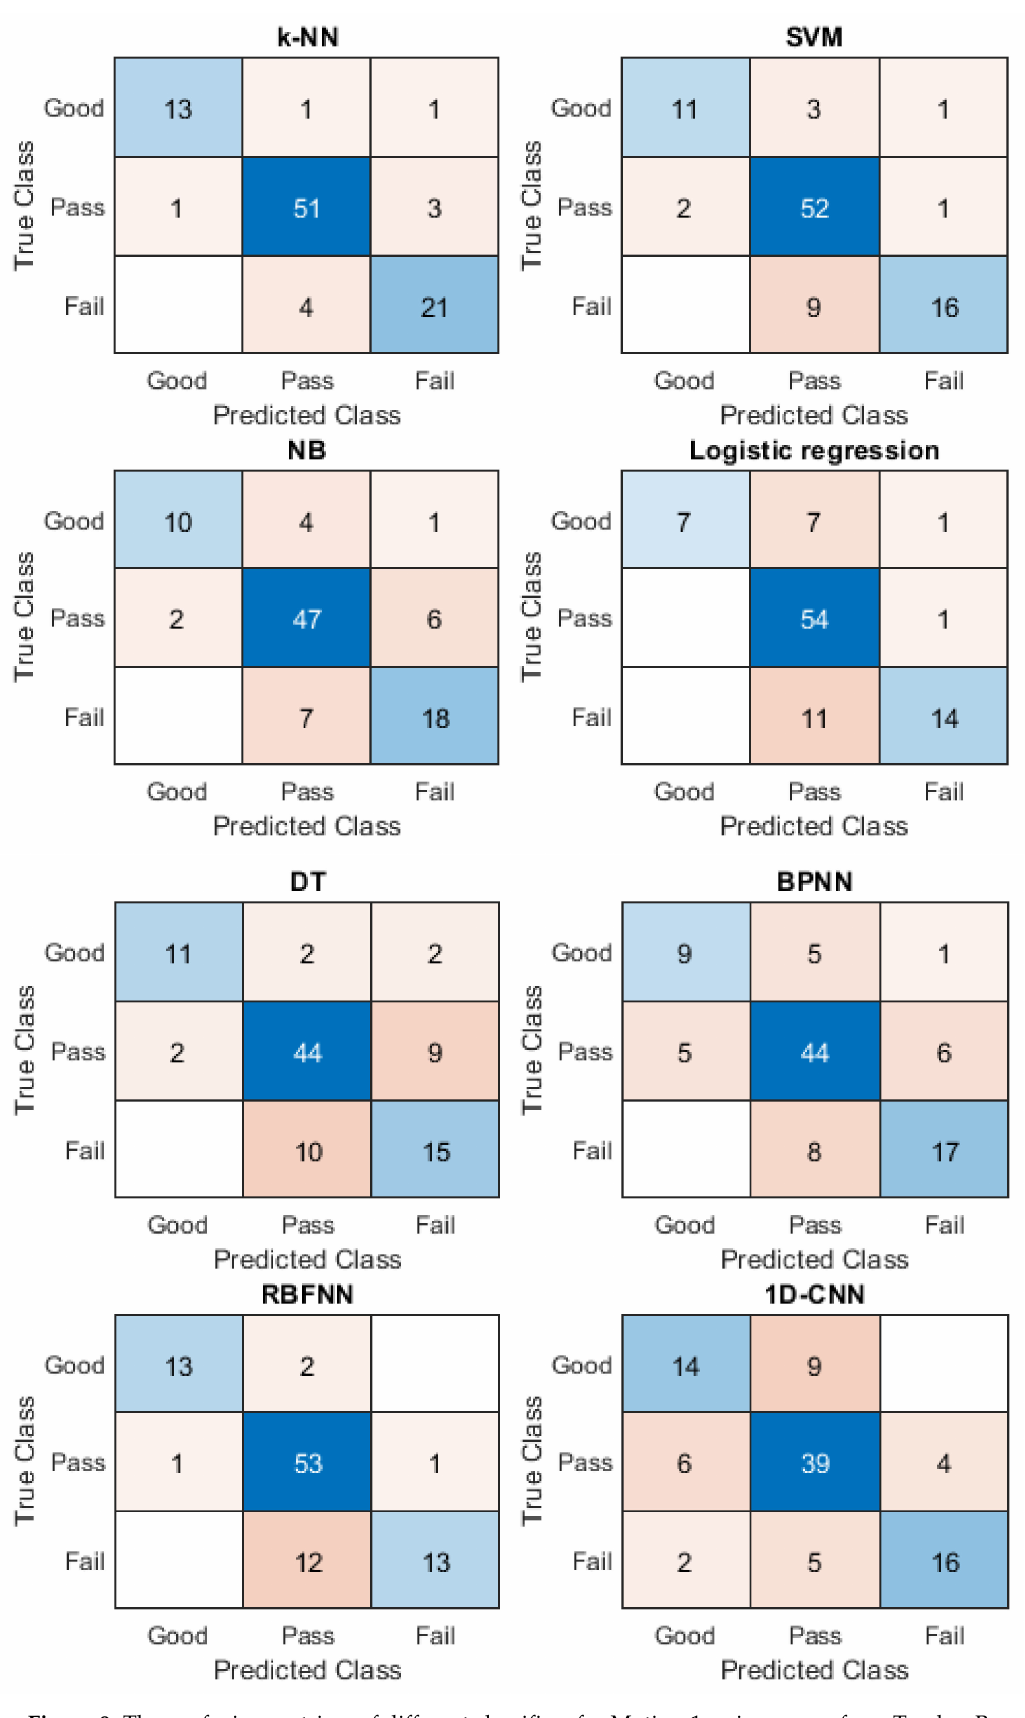
Figure 9. The confusion matrices of different classifiers for Motion-1, using scores from Teacher